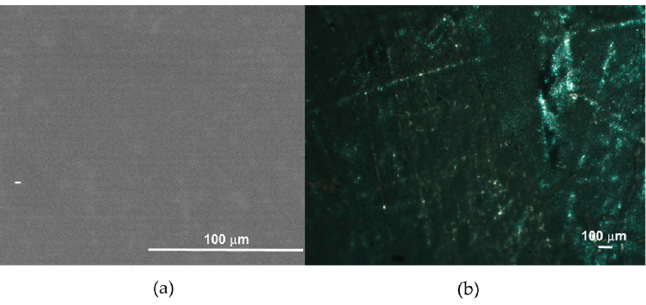
Figure 2. SEM ( a ) and POM (crossed polarizers) ( b ) images of the d-PCL(530)/siloxane 9.1 LiTrif- [Er(tta) 3 (H 2 O) 2 ] electrolyte.